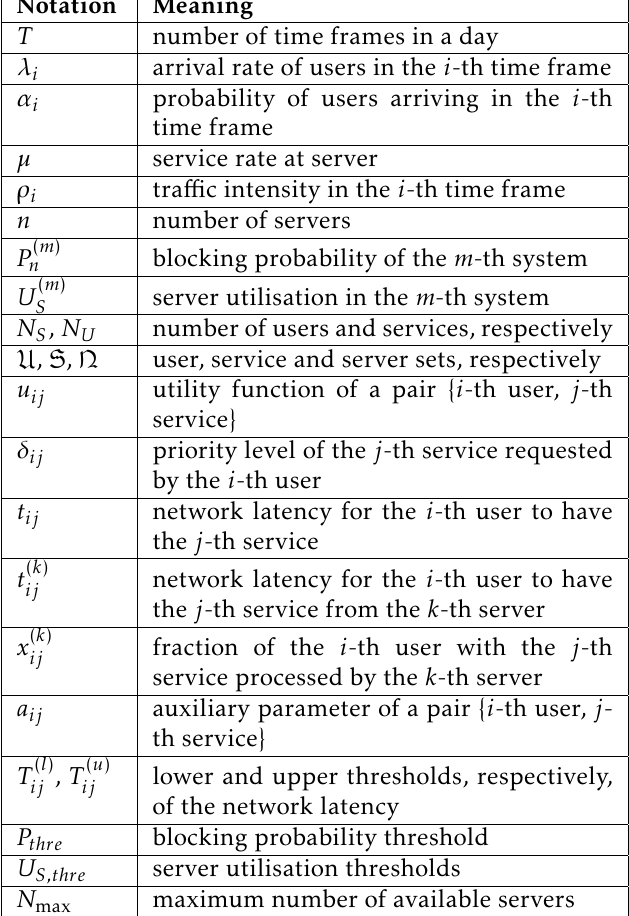
Table 1. Summary of main